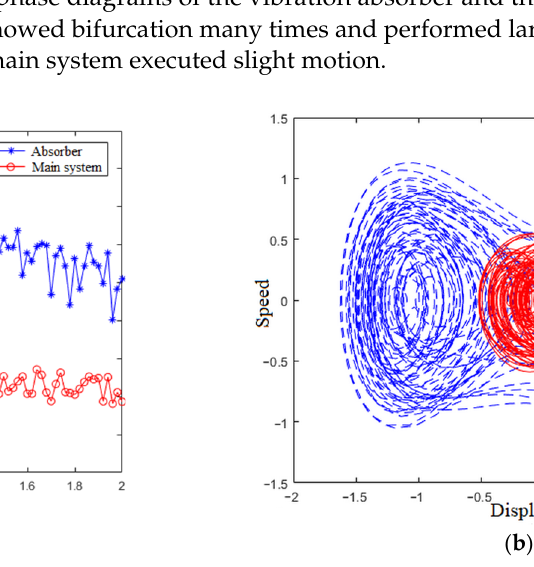
Figure 15. Response amplitude and phase diagram of two vibrators in the case of off-resonance ω = 0.6. ( a ) Response amplitude; ( b ) Phase diagram ( β = 0.3).